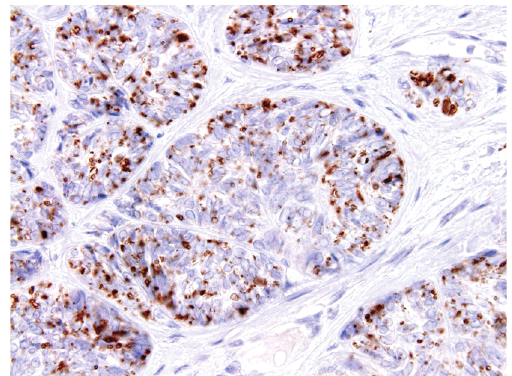
Figure 7: Sebocytes seen at the periphery of the tumor nests are positive with